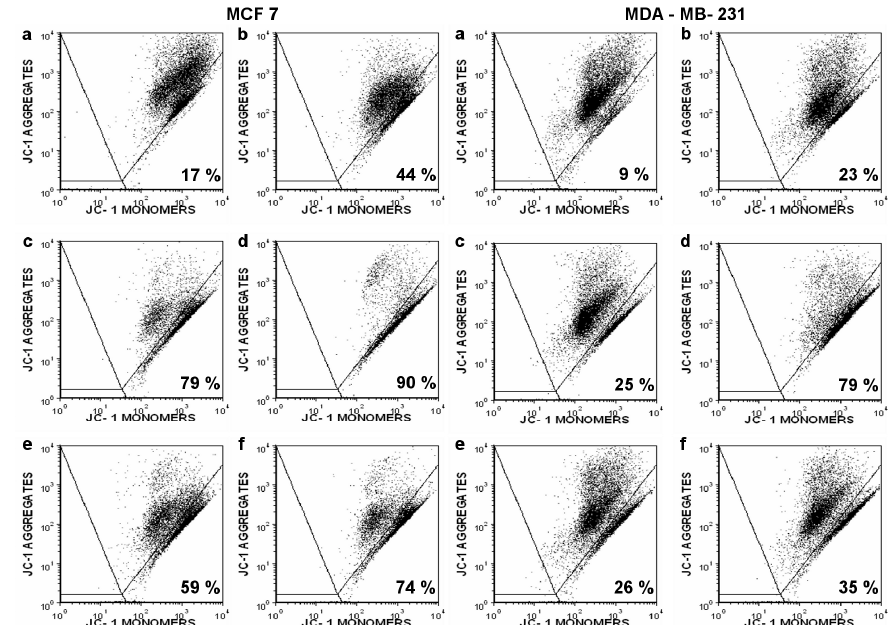
Figure 5. The mitochondrial membrane potential disruption by triorganotin isothiocyanate derivatives in MCF 7 and MDA-MB-231 cells measured by flow cytometry (JC-1 staining). The percentage of cells with depolarized ∆ ψ m (JC-1 monomers) is indicated in the right lower quadrant after following treatment: ( a ) control, ( b ) Taxol 1 µ M (positive control), ( c ) TBT-ITC 500 nM, ( d ) TBT-ITC 1 µ M, ( e ) TPT-ITC 500 nM, and ( f ) TPT-ITC 1 µ M. The data presented are representative dot plots of three independent experiments.